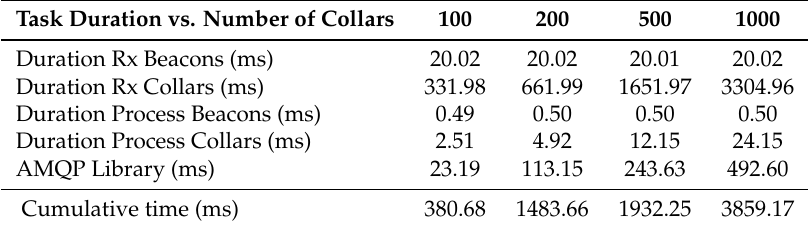
Table 3. The Median Duration of the Most Important Tasks Running on the Gateway.